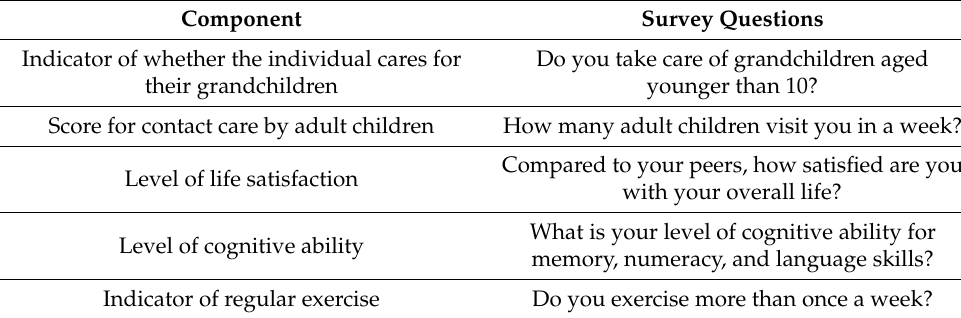
Table 2. Survey questions to assess explanatory variables.